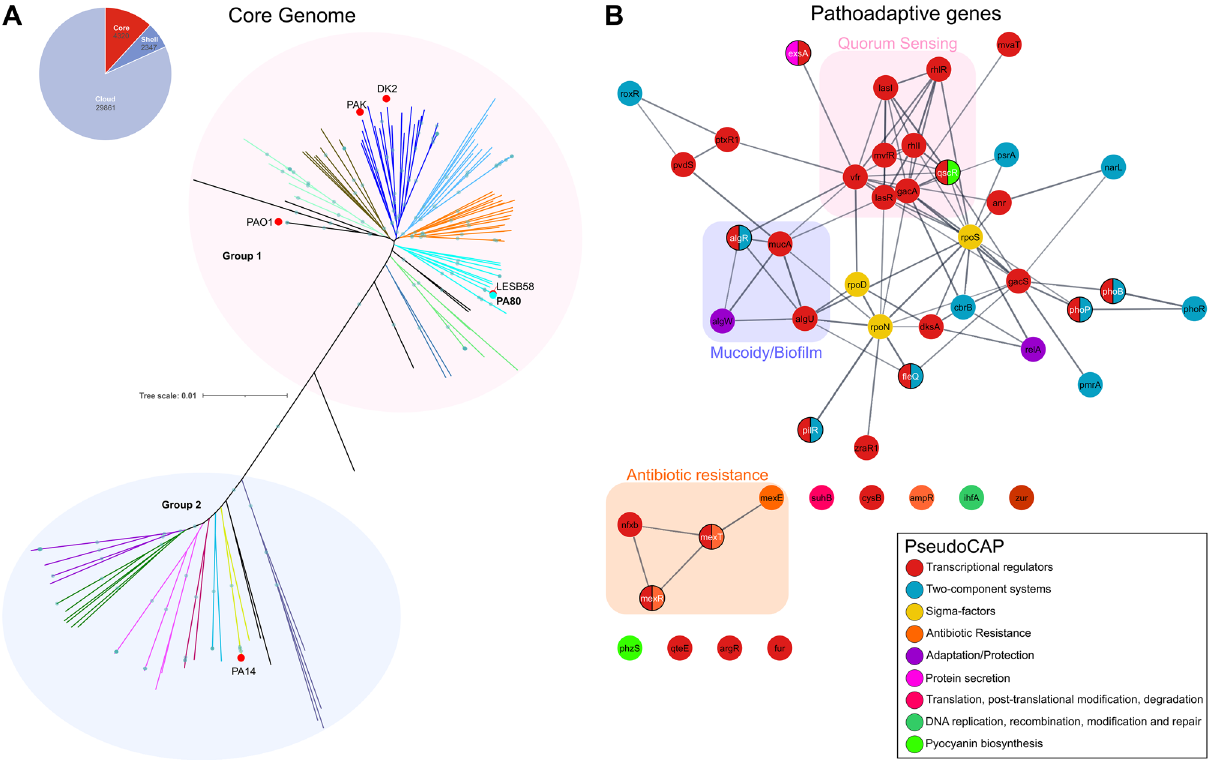
Figure 2. Core genome phylogeny of P. aeruginosa . ( A ) Maximum likelihood phylogenetic tree of P. aeruginosa core genome. PA80 clusters with hypervirulent Liverpool Epidemic strains LESB58 and LES431. The widely referenced PAO1 strain is distinctly separate from more virulent strains that have been isolated from Cystic Fibrosis patients. Important P. aeruginosa strains are highlighted by red dot, strain PA80 is indicated by a cyan dot. The number of genes determined in the core across 95% of the P. aeruginosa isolates are shown inset in the pie chart. ( B ) A STRING interaction network to show common pathoadaptive genes (n = 47) that can be mutated in P. aeruginosa isolates from CF patients. Genes are colored based on Pseudocap annotations. Note— the following proteins are not found in the STRING database vqsR, rsaL, pprB , PA4851, PA152, and are not shown in the